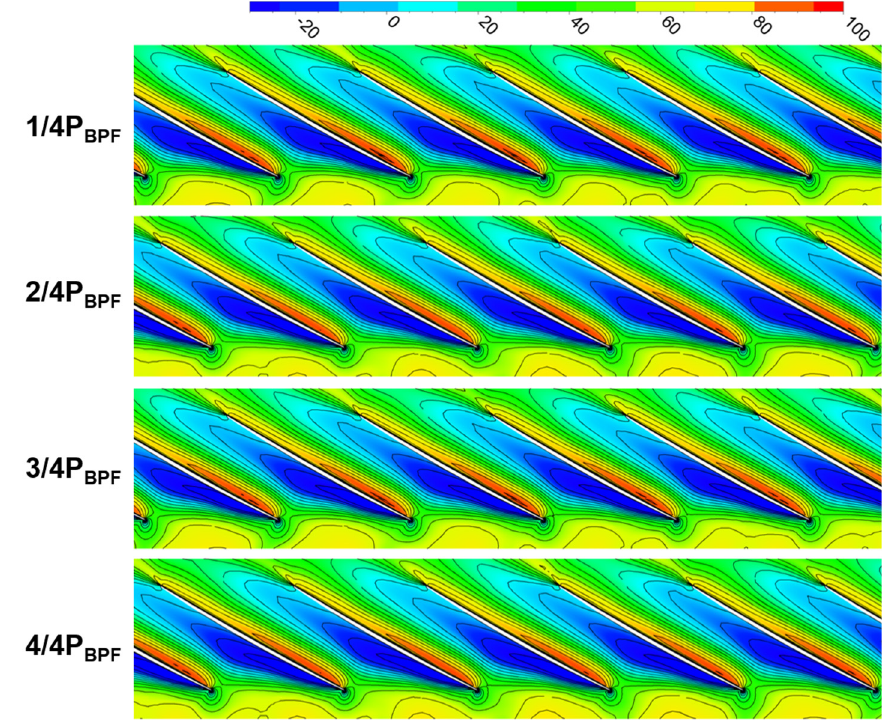
Figure 12. Axial component of velocity under NS condition, 99.35% of span, P BPF is the period of the blade passing.